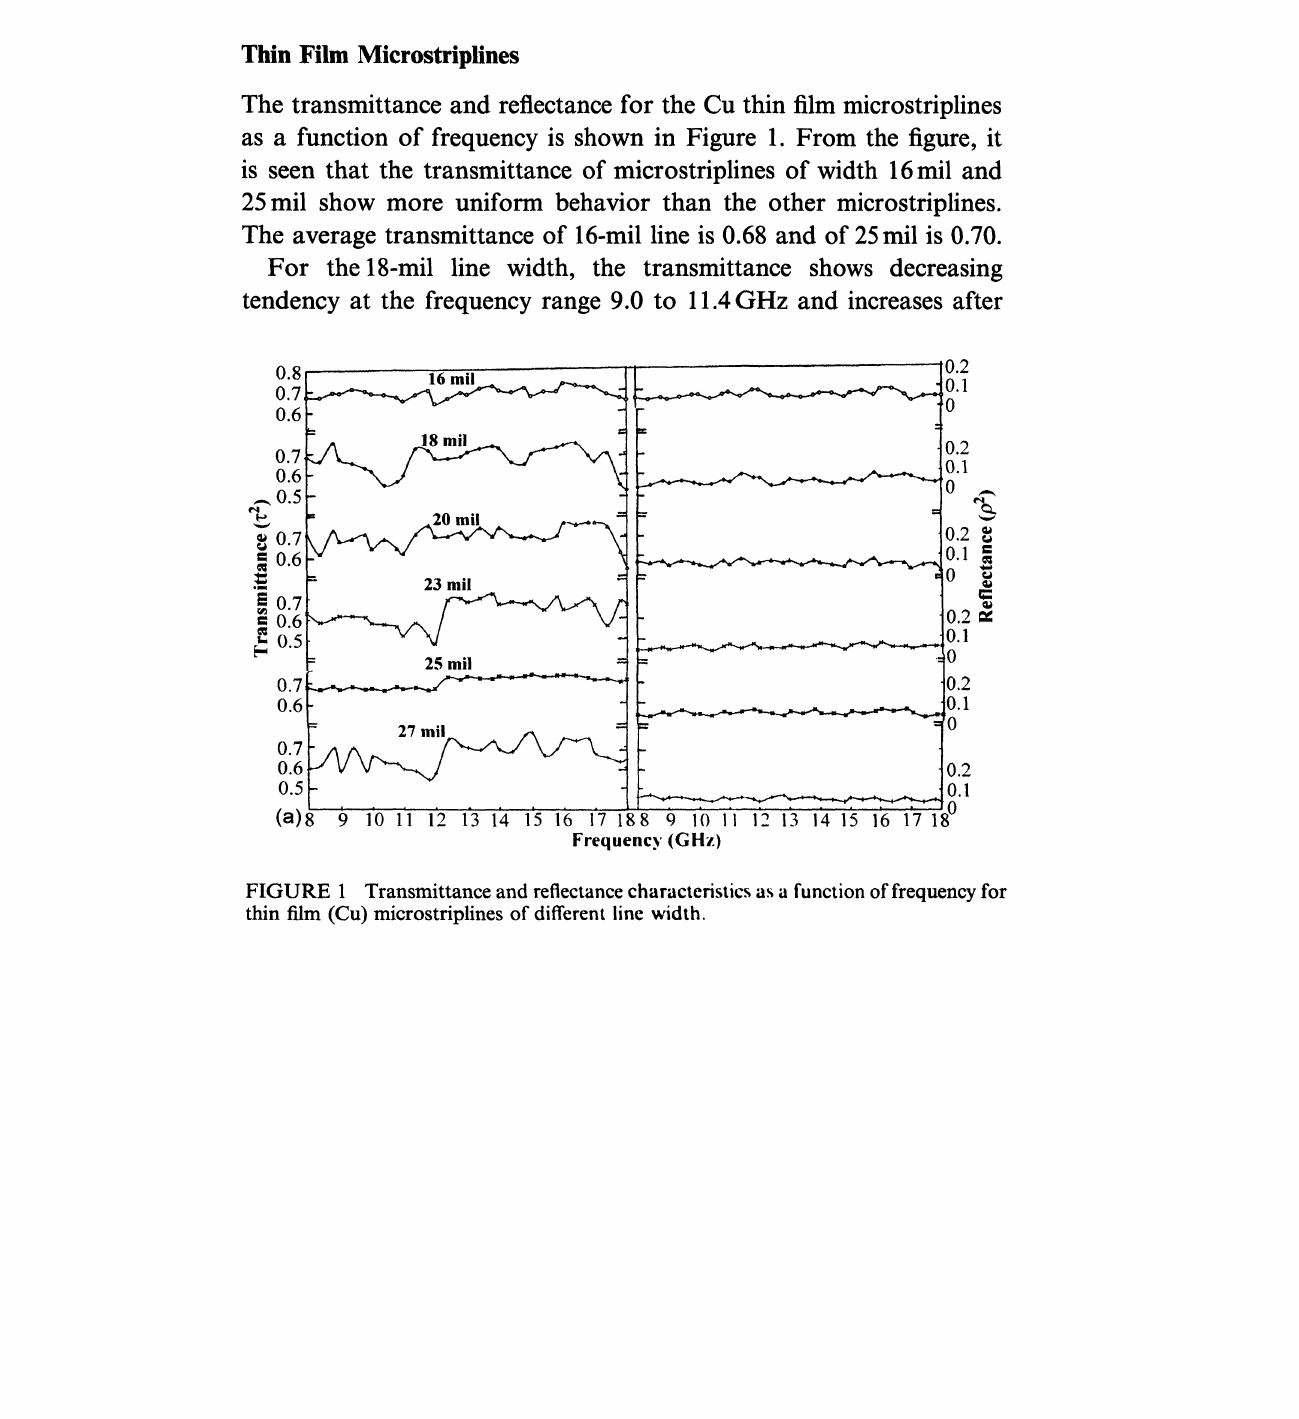
Transmittance and reflectance characteristics as a function of frequency for thin film (Cu) microstriplines of different line